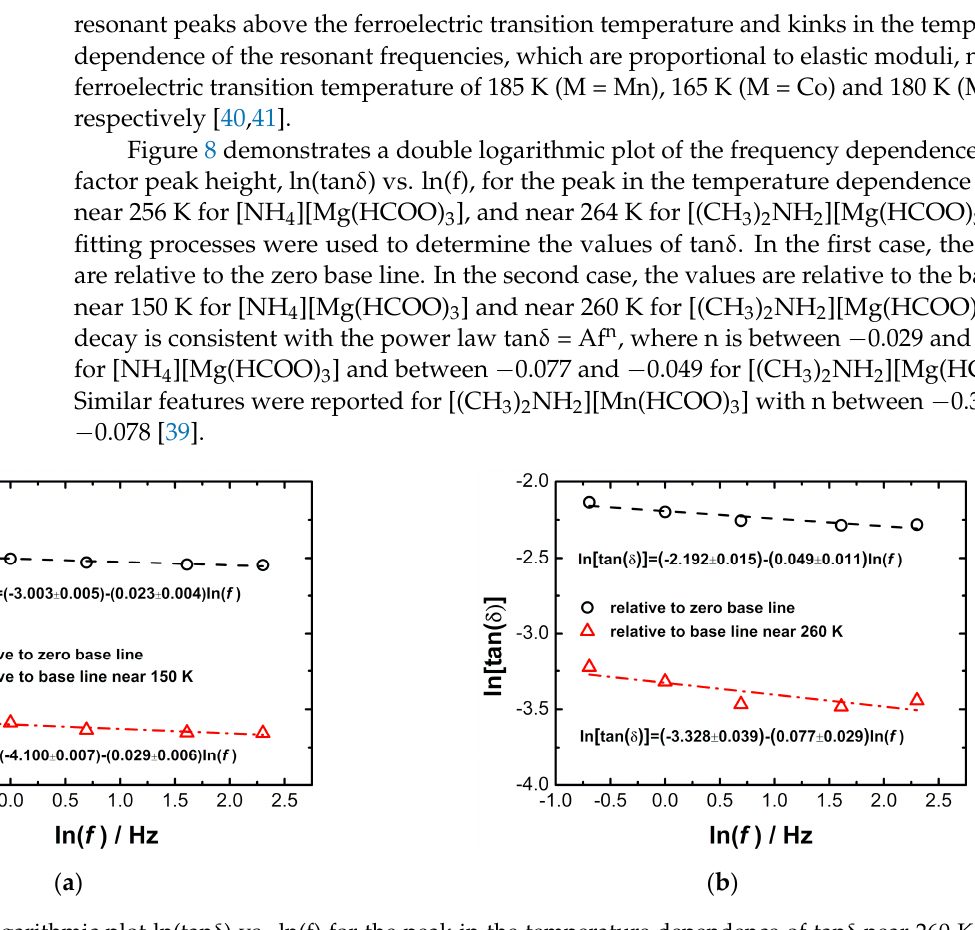
Figure 8. Double logarithmic plot ln(tan δ ) vs. ln(f) for the peak in the temperature dependence of tan δ near 260 K in [NH 4 ][Mg(HCOO) 3 ] ( a ) and near 270 K in [(CH 3 ) 2 NH 2 ][Mg(HCOO) 3 ] ( b ).